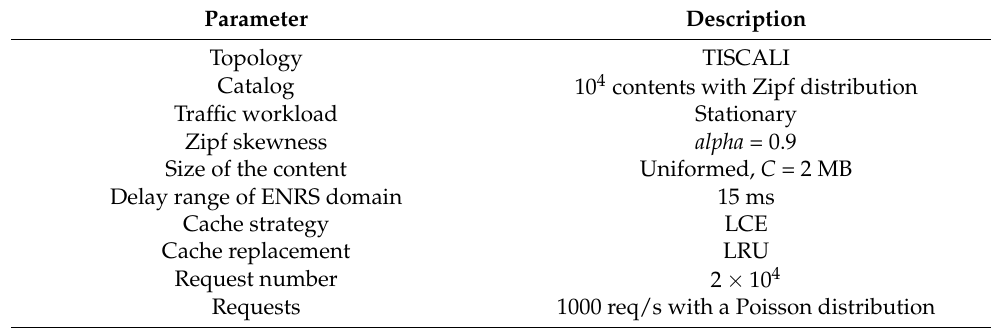
Table 5. Simulation